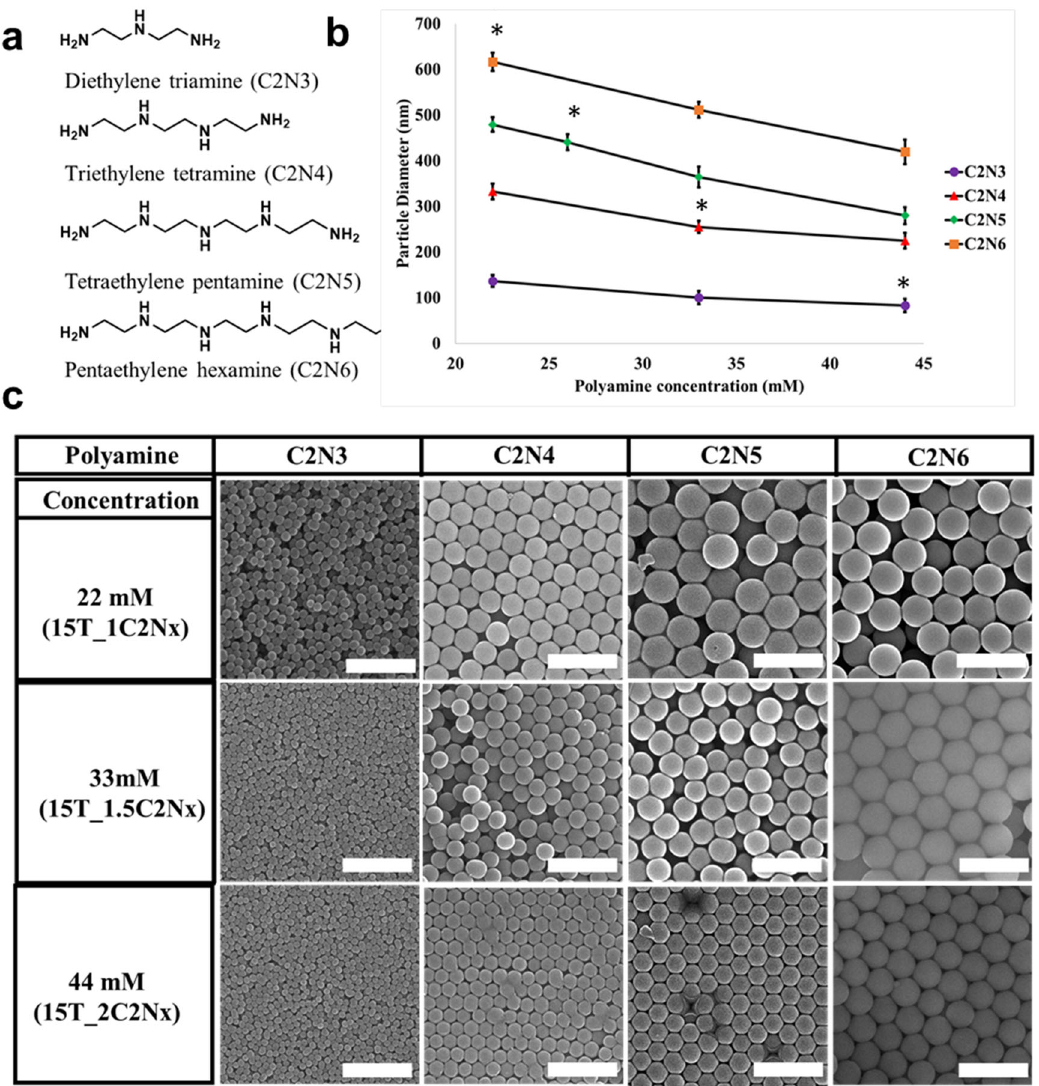
Fig. 1 Bioinspired silica synthesis using polyamines of different chain lengths and concentrations. a Molecular structures of polyamines. b Plot of average silica particle diameter ( n = 100; error bars represent stand deviation) obtained using SEM images of particles grown in presence of different polyamines and at different polyamine concentrations (data points marked with * correspond to the particle diameters obtained at a constant Si:N ratio of 2.5:1), and c SEM images of fi nal particles grown at various polyamine concentrations (22 – 44 mM (the corresponding mole ratios in brackets)) using 330 mM silicic acid concentration in aqueous phase. Scale bars 1 µ